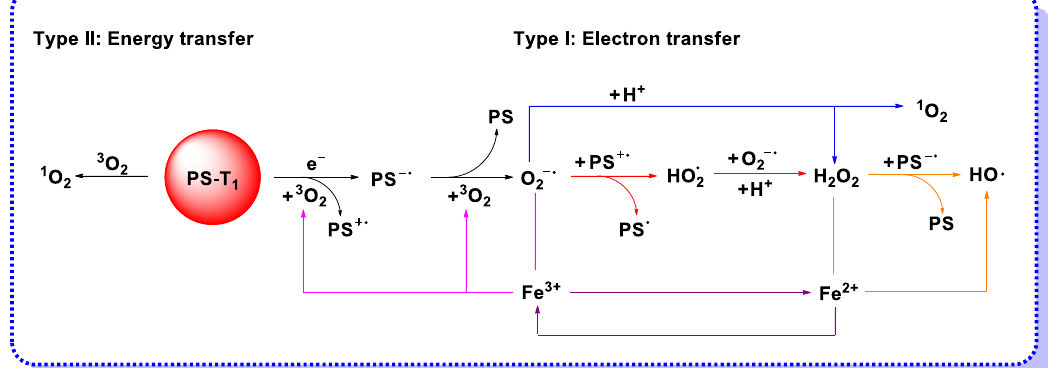
Figure 3. ROS generation mechanism: Type I electron transfer to form free radical ROS and hydrogen peroxide, and Type II energy transfer to form singlet oxygen.